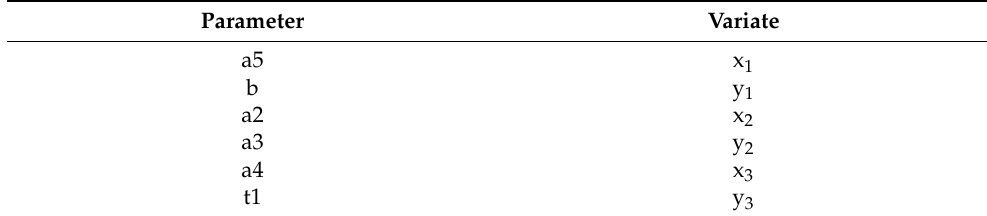
Table 3. The variables are defined by each